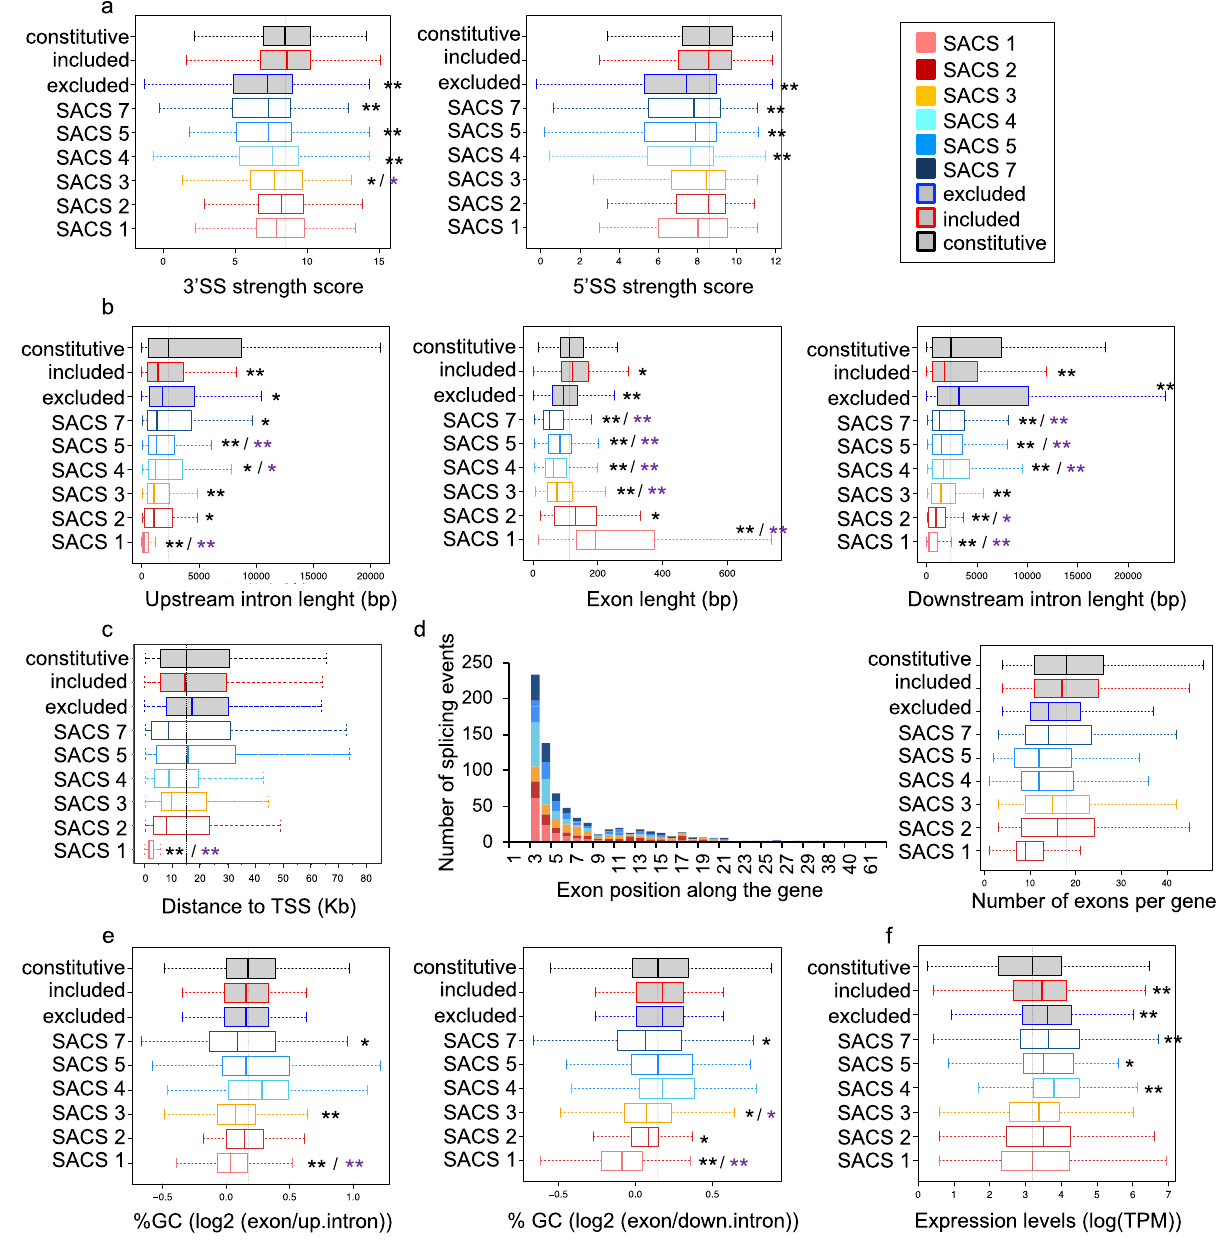
Fig. 5 The genetic features of chromatin-marked alternatively spliced exons (SACS). a Box plots of the 3 ′ and 5 ′ splice site (ss) strength scores. b Box plots of exon and upstream and downstream intron lengths (in bp). c Box plot of the distance in Kb to the transcription start site (TSS). d Cumulative bar graph representing the number of splicing events at each exon position along the gene and box plot of the number of exons per gene. e Box plots of the log2 ratio of the percentage of GC content at the alternatively spliced exon respect the upstream or downstream fl anking intron. f Box plot of the normalised gene expression levels, represented as log(TPM). Each chromatin-marked splicing group (SACS) has its own colour code as indicated in legend. Box plots are centred on the median with interquartile ranges of all the exons enriched in a particular SACS with SACS1 exons n = 165, SACS2 exons n = 142, SACS3 exons n = 143, SACS4 exons n = 152, SACS5 exons n = 89, SACS7 exons n = 139, non-marked excluded exons n = 600, non-marked included exons n = 600 and Constitutive exons n = 600. Constitutive exons (in grey + black) and non-marked excluded + mid-excluded (in grey + blue) and included + mid-included (in grey + red) exons are used as controls. * p -value < 0.01 and ** p -value < 0.001 in Wilcoxon rank test, two-sided, compared to constitutive exons (in black) or the corresponding alternatively spliced control exons (in